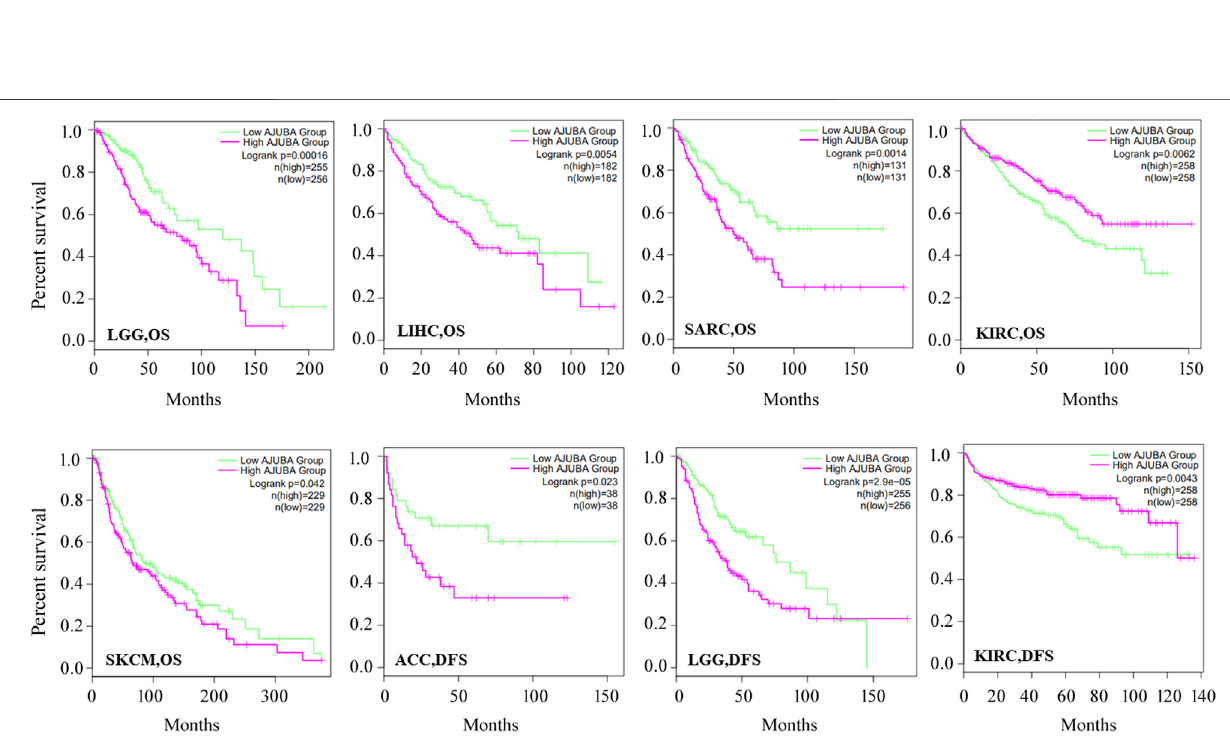
Frontiers in Cell and Developmental Biology |